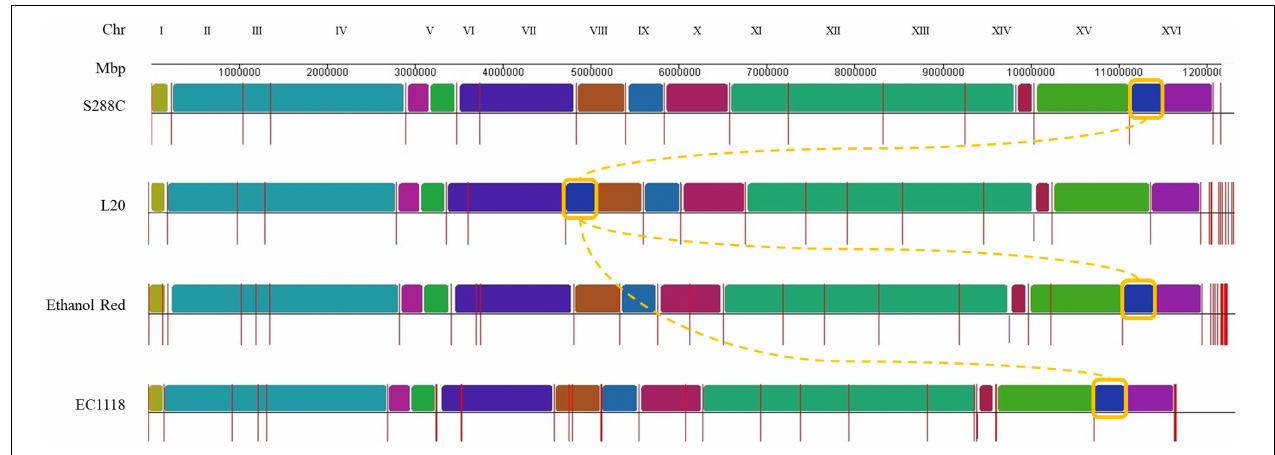
FIGURE 3 | Multiple genome alignment of selected S. cerevisiae strains. The newly sequenced L20 and Ethanol Red genomes are compared to the reference S288C and with EC1118 strains. Chromosomes are ordered according to the S288C strain (first row) and syntenic regions are represented using different colors. Contiguous regions (chromosomes or scaffolds) are separated by red vertical bars. The translocation identified in L20 is highlighted using a yellow box.